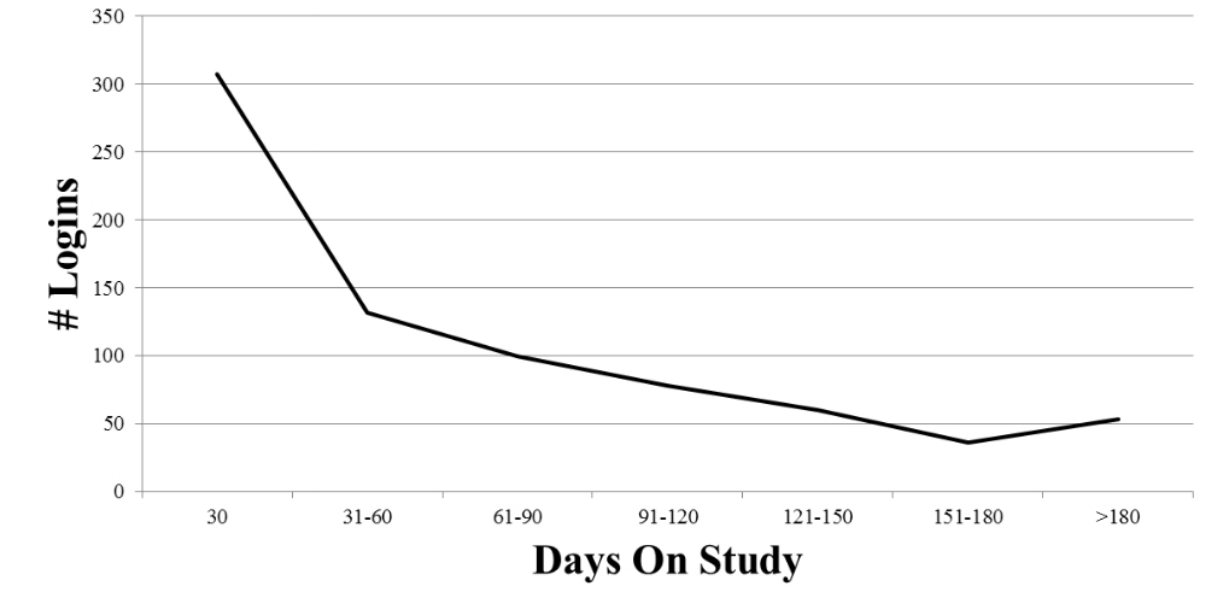
Figure 3. Number of log-ins into the SLIDES